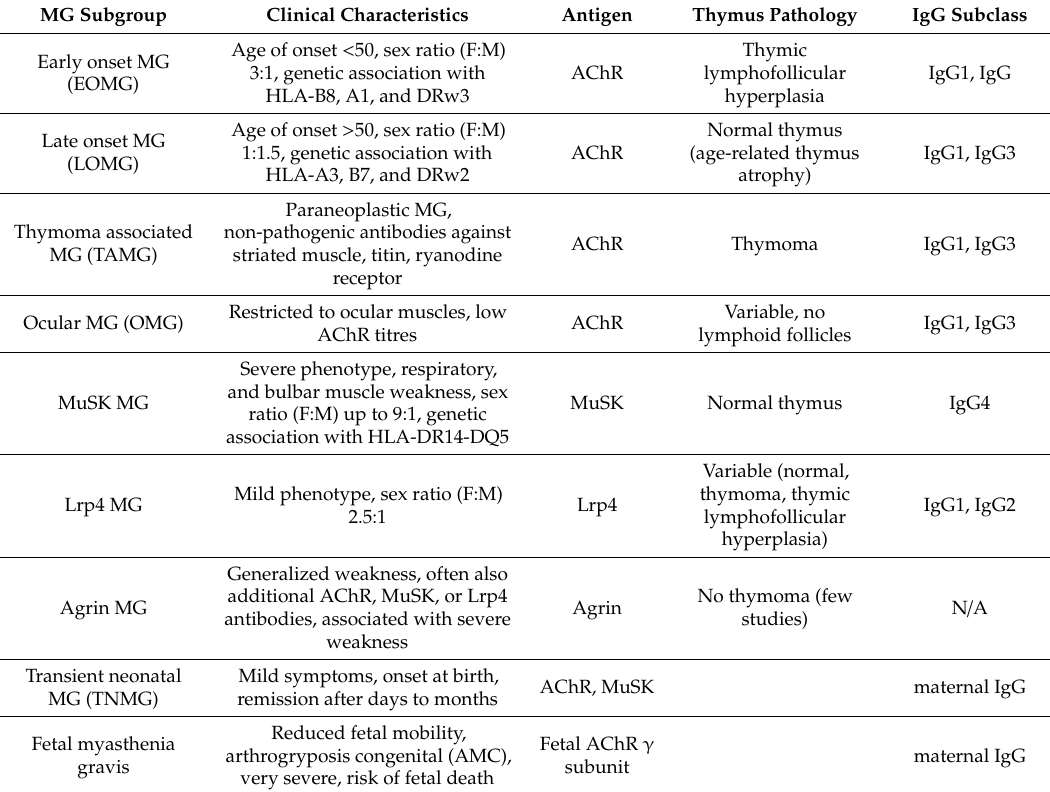
Table 1. Clinical subgroups of myasthenia gravis (modified from